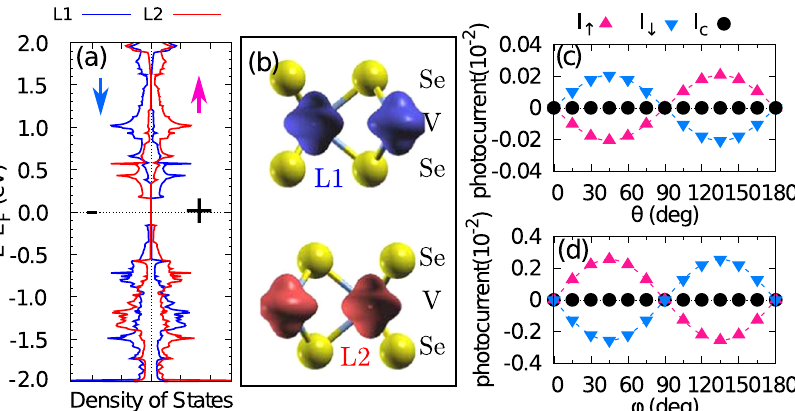
Fig. 7 Electronic properties and photocurrent of the bilayer 2H-VSe 2 . a The layer-projected DOS of the bilayer 2H-VSe 2 . L1 (L2) denotes the fi rst (second) layer of bilayer VSe 2 . Positive (negative) value of DOS represents spin-up (-down) component. b The spin density of the bilayer 2H-VSe 2 . The spin-dependent and total charge photocurrent under c LPL and d EPL with E ph = 0.65